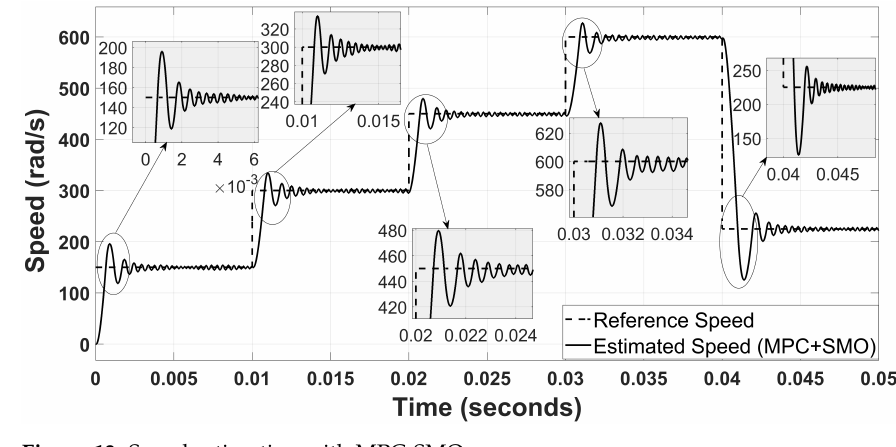
Figure 13. Speed estimation with MPC-SMO.